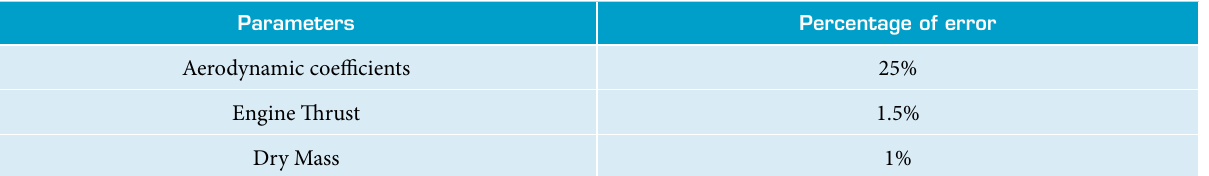
Table 1. Error value percentage of